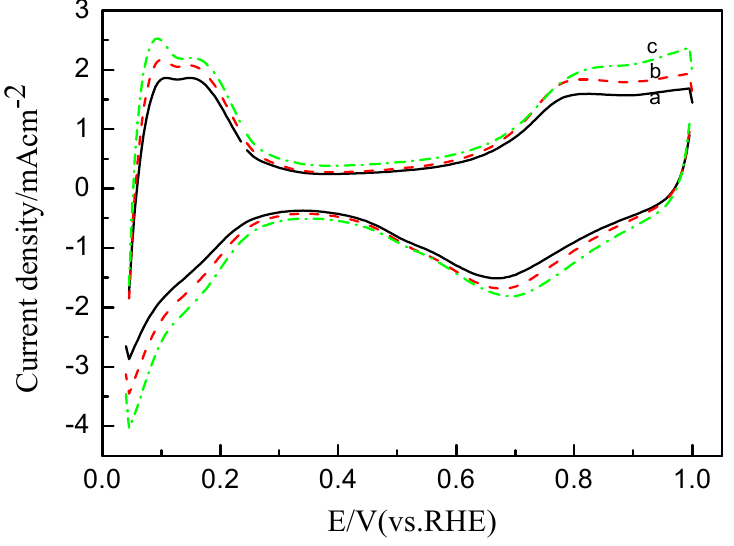
Figure 4. CVs of Pt/C catalytic electrodes with the catalyst ink pre-heated at ( a ) 25 °C; ( b ) 50 °C and ( c ) 80 °C in 0.1 M HClO at a scan rate of 50 mV s − 1 . 4